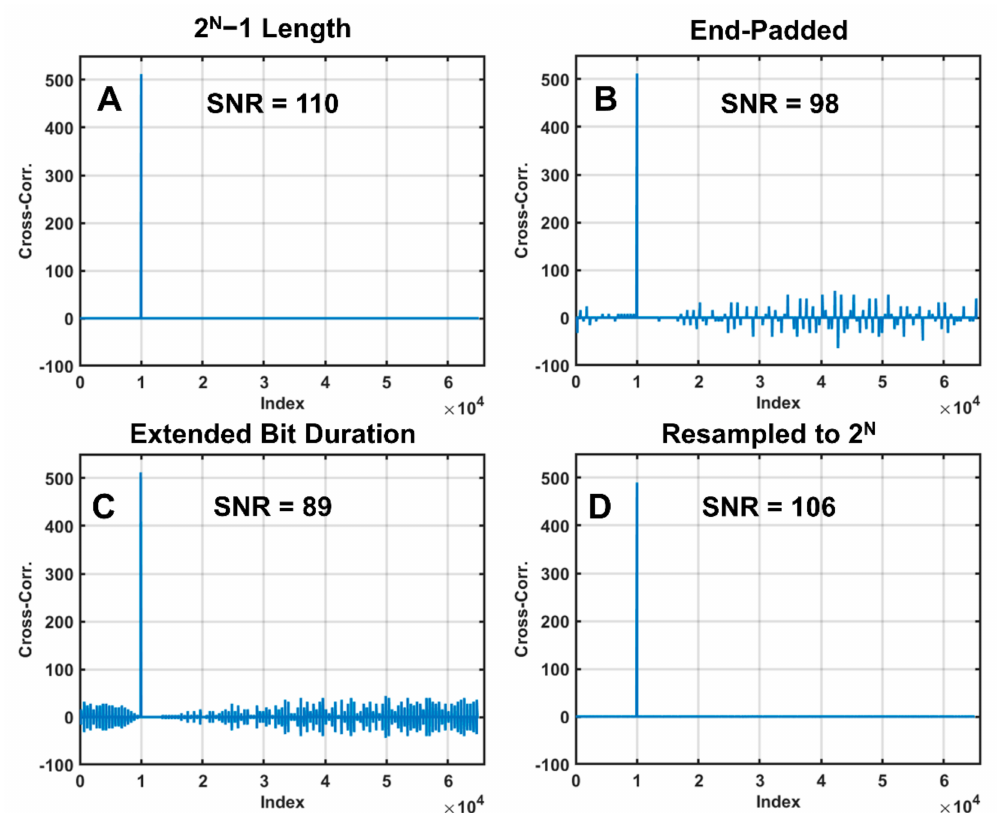
Figure 2. Cross-correlation results comparing various methods of extending PN code and kernel to 2 N . All codes were given a synthetic range of 10,000 prior to cross-correlation. ( A ) PN code correlation with 2 N − 1 bits and other parameters from Table 1 (length: 65,024). ( B ) Correlation result after zero-padding of length 512 at the end of the code and kernel. ( C ) Correlation result after lengthening bit duration to 516 bins and zero-padding of length four at the end of the code and kernel. ( D ) Correlation result after resampling the code and kernel used in ( A ) to length 2 N . The SNR is the peak value of the cross-correlation peak divided by the standard deviation of the cross-correlation at all other